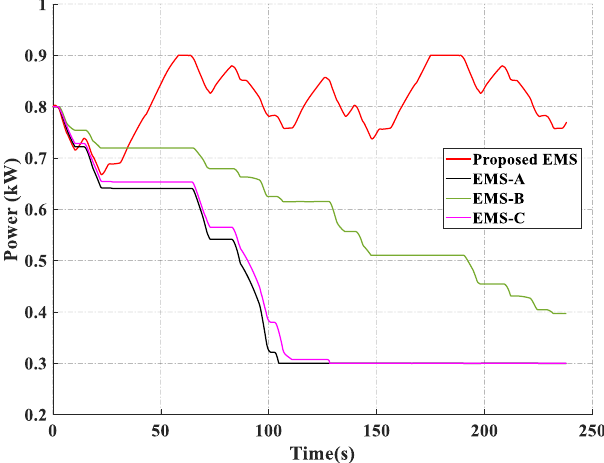
Figure 20. State of charge of the supercapacitor.